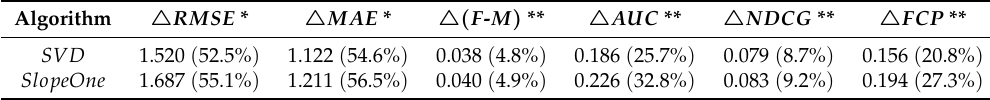
Table 6. Level of accuracy improvement between MC - SVD and the single-rating techniques. Algorithm